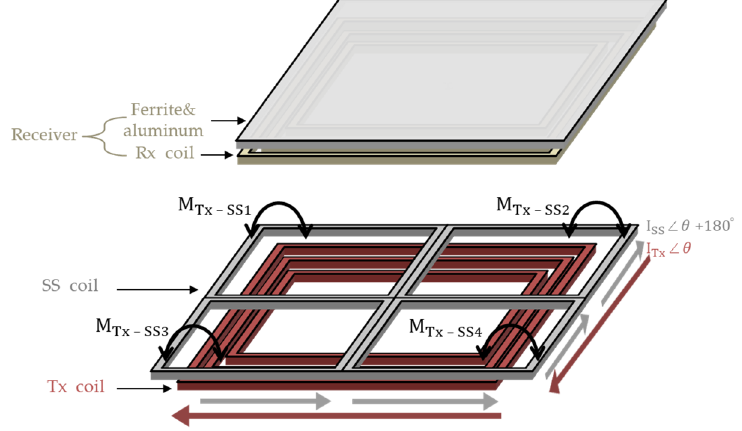
Figure 2. WPT system to which SS coils for reducing a leakage magnetic field and detecting a receiver position is applied.